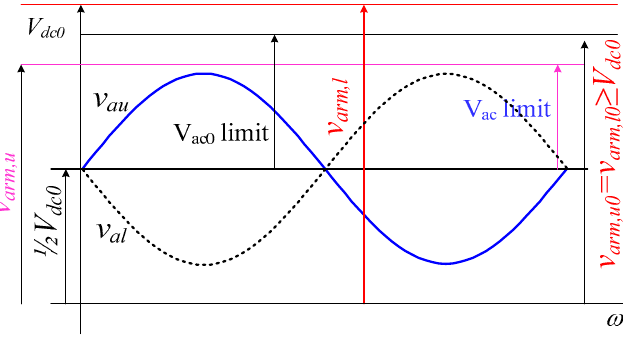
Figure 6. Arbitrary arm voltage of the MMC that suffers from unequal capacitor voltage sums in the upper and lower arms of the same phase-leg.